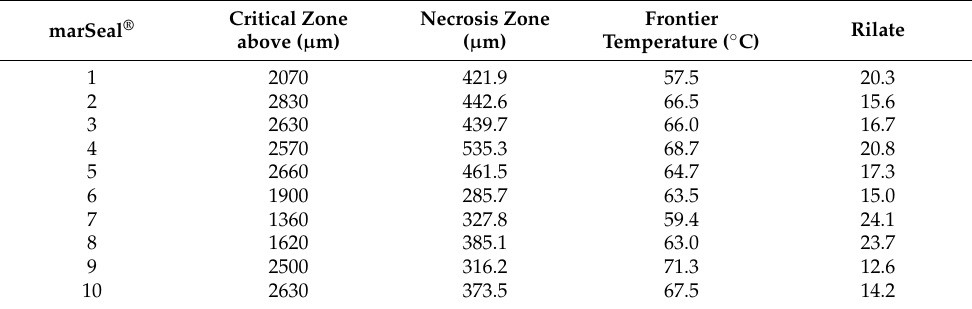
Table 1. Overview of the expansion of the critical zone, the necrosis zone, the height of the tempera- ture at the end of the necrosis zone, and the indices ( n = 15 per group) for the instruments marSeal ® 5 plus and BiCision ®